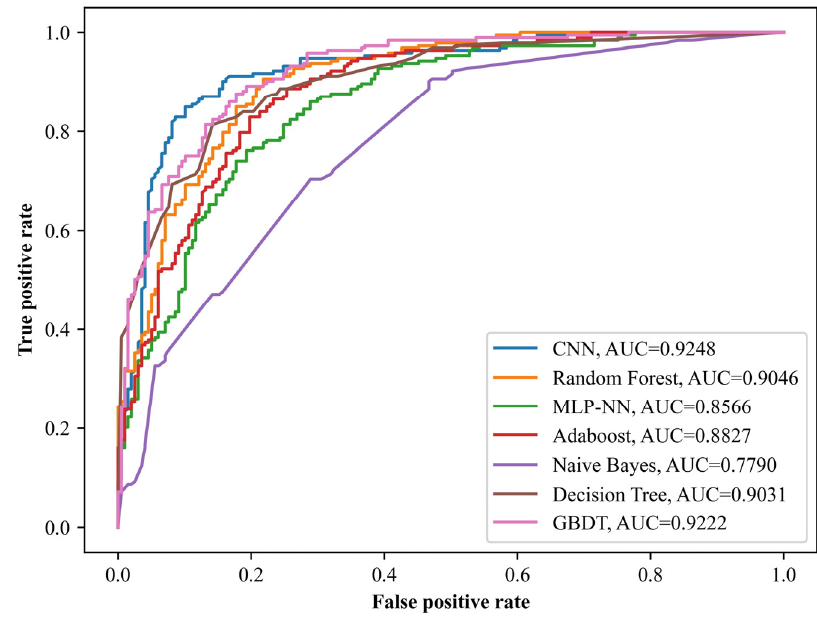
Figure 7. ROC of the models. Table 4. Model performance comparison. Table 4. Model performance